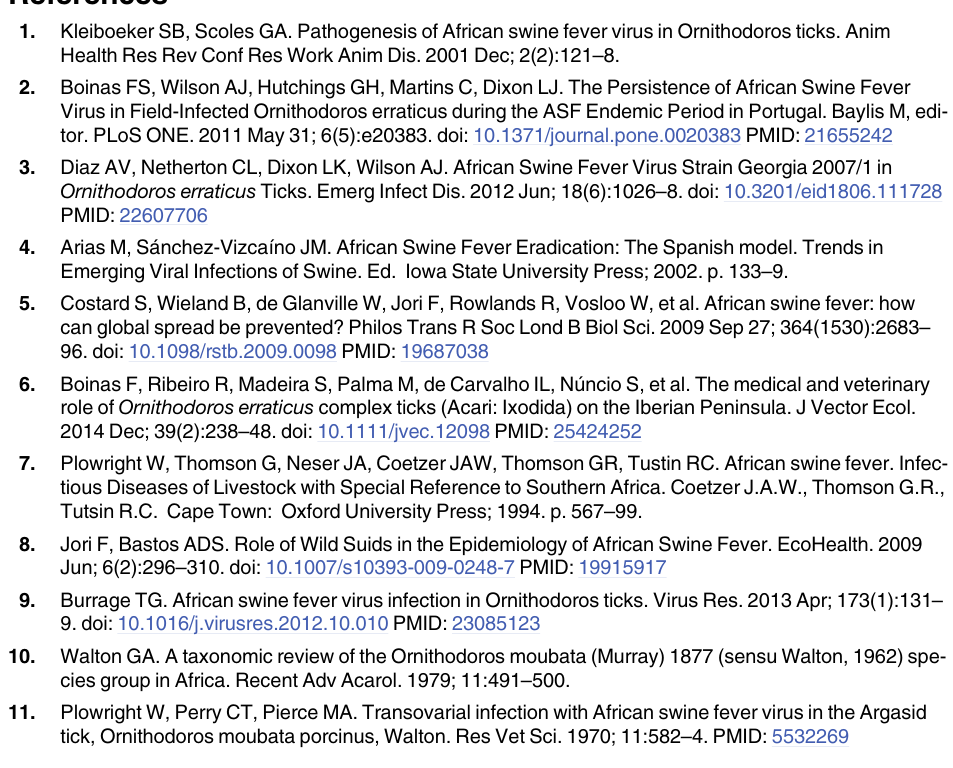
S5 Table. Logistic regression model C — Effect of route of exposure (Pig feeding versus inoc- ulation and membrane feeding) and titre of exposure (high and low titres), controlling for tick stage and days post exposure, in infection (n = 499), LVE (n = 499) and LVE within the infected ticks (n = 137). Value of coefficients and odds ratio for the variables with statistical significance. S6 Table. Dataset of all experiments performed to investigate the dynamics of infection of Ornithodoros erraticus sensu stricto ticks with two strains of African swine fever virus.